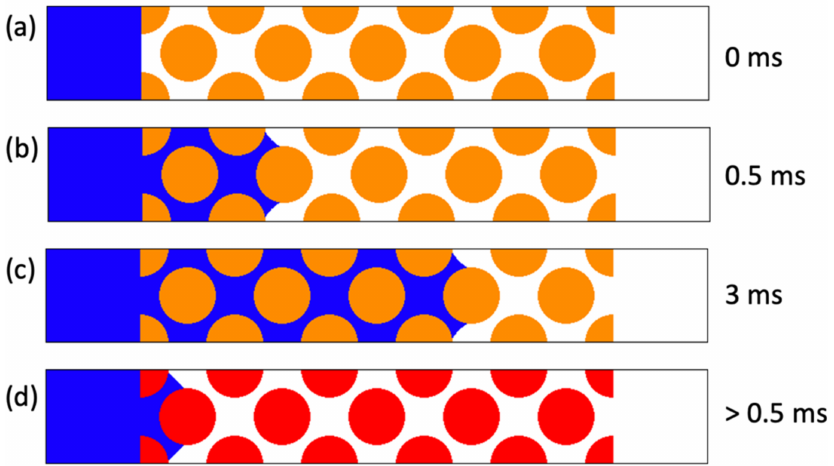
Figure 10. Infiltration for homogeneous coating with CA = 50 ◦ at ( a ) simulation start, ( b ) 0.5 ms,